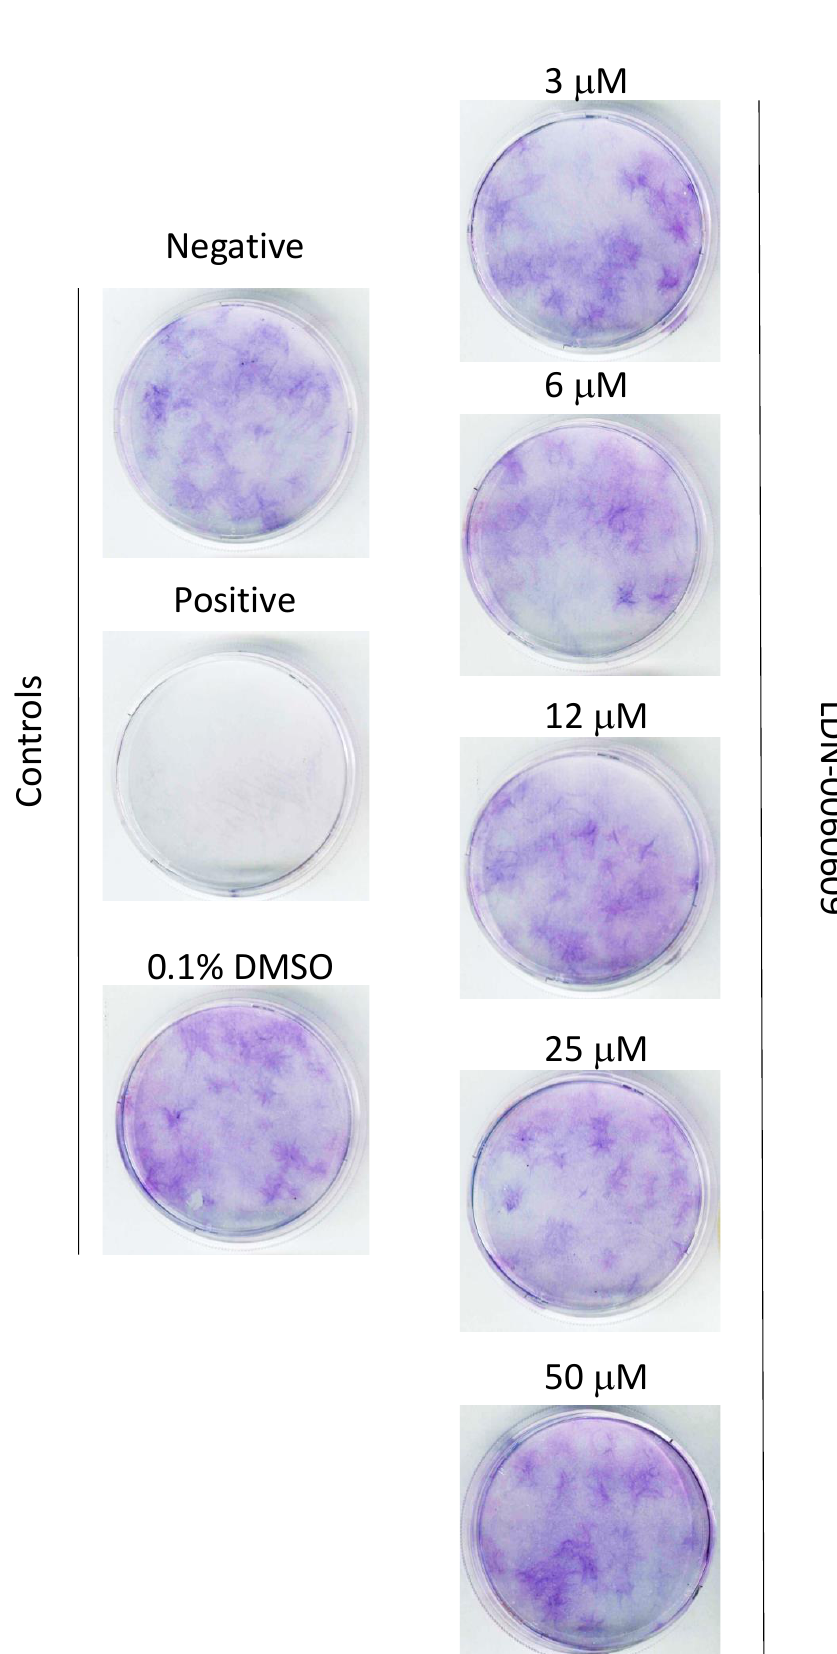
Figure 5. Cell survival assay on HTM cells treated with the PERK inhibitor LDN-0060609 at indicated concentrations (3–50 µ M). DMSO—dimethyl